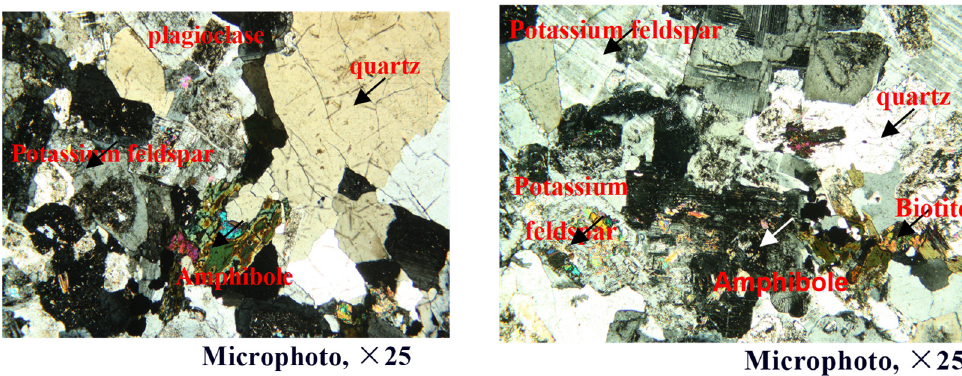
Figure 7. Thin section micrographs of the PL granite buried-hill. The ( left ) figure shows the thin section of Well 13, with a depth of 1502.8 m and a granodiorite lithology; the ( right ) picture shows the thin section of Well 2, with a depth of 1346 m and which is monzogranite.